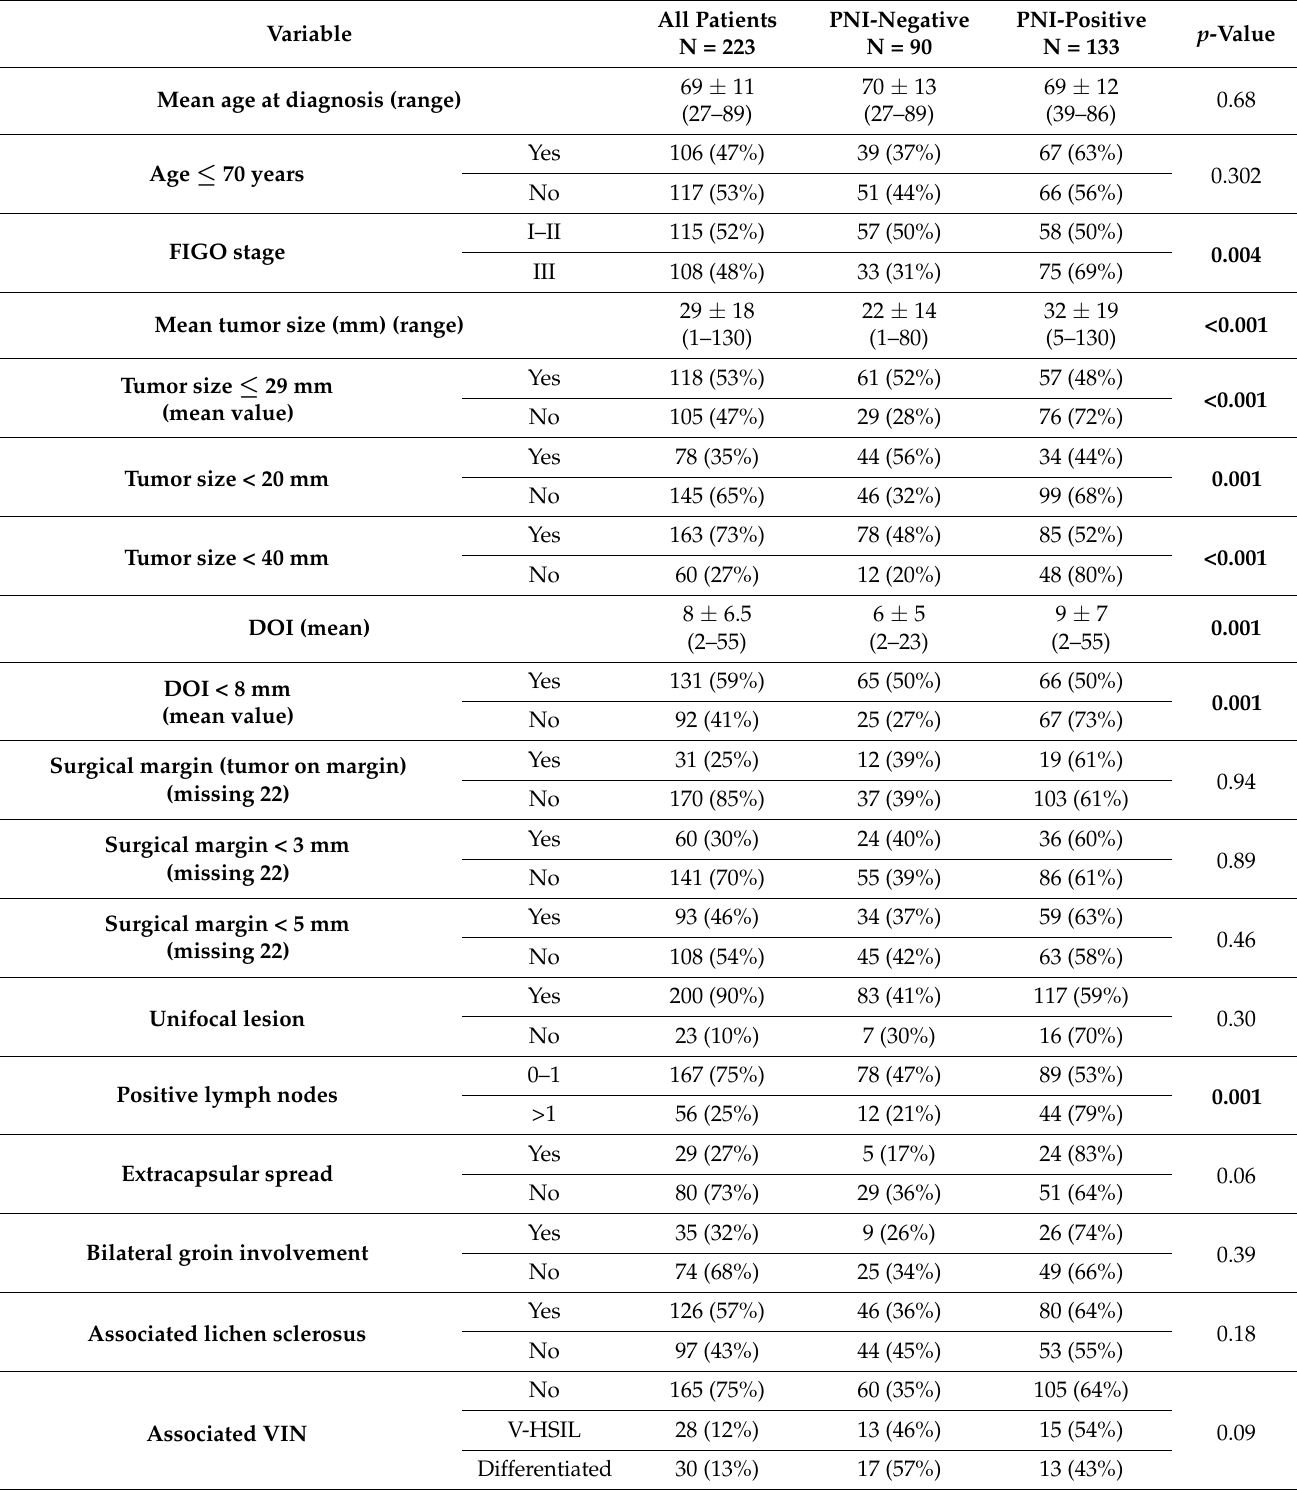
Table 1. Demographic, clinical, surgical, and histopathological characteristics of the whole cohort, and according to the presence of PNI. (Statistically significant factors are highlighted in